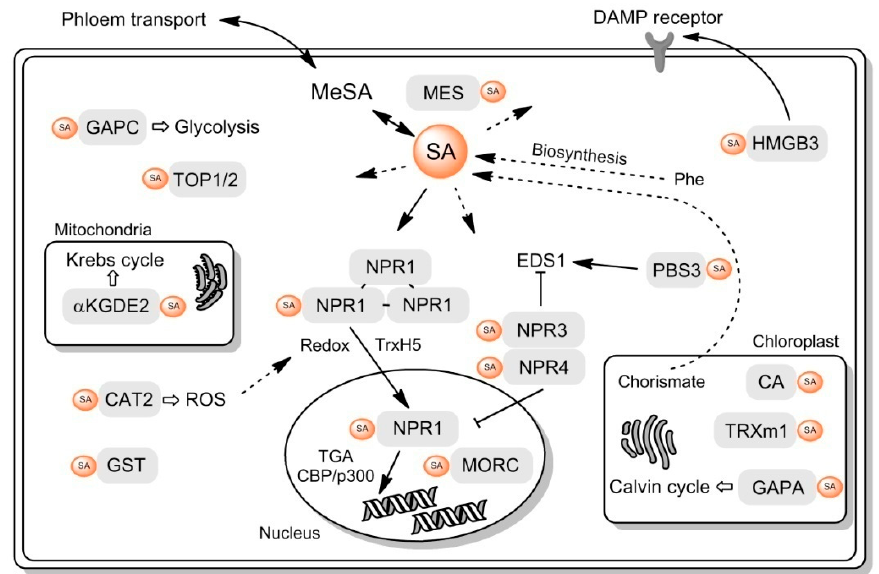
Figure 5. Schematic representation of putative functional roles of SABPs in cell metabolism. Phe, phenylalanine; DAMP, damage-associated molecular pattern; ROS, reactive oxygen species. See the main text for protein abbreviations. Solid arrows represent single enzymatic steps. Dashed arrows represent multiple consecutive enzymatic steps. Hollow arrows represent functional connections to cell activities.